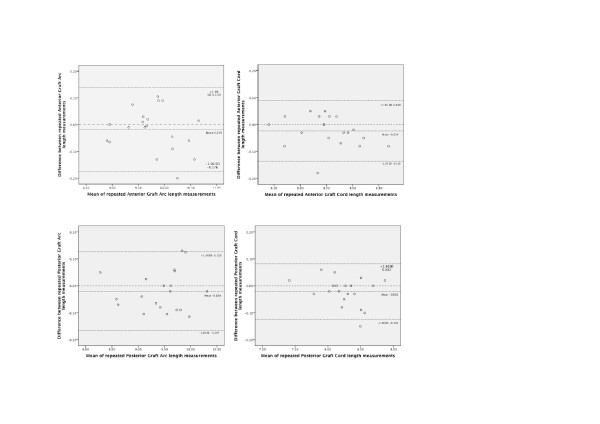
Band Altman Plots for Intraobserver agreement of Graft Parameters (Anterior graft Arc Length, Anterior Graft cord length, Posterior Graft Arc length, Posterior Graft Cord Length)